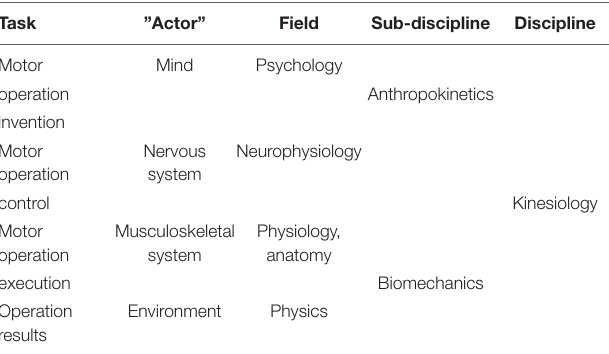
TABLE 1 | The system of sciences on motor behaviour of a human (Petry´nski, 2019, p. 29). Task